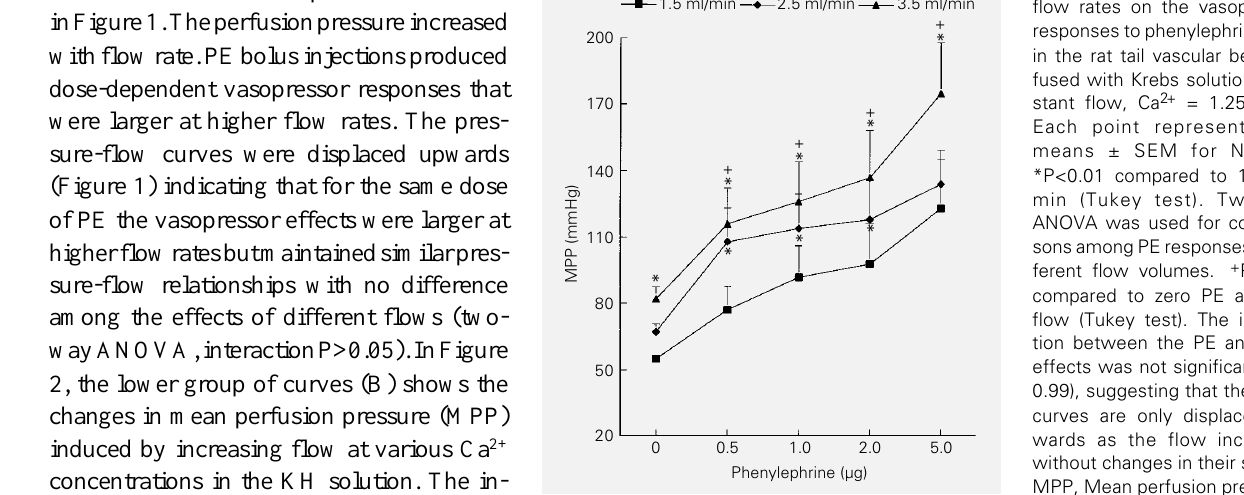
Figure 1 - Effects of 3 different flow rates on the vasopressor responses to phenylephrine (PE) in the rat tail vascular bed per- fused with Krebs solution (con- stant flow, Ca 2+ = 1.25 mM). Each point represents the means ± SEM for N = 8. *P<0.01 compared to 1.5 ml/ min (Tukey test).